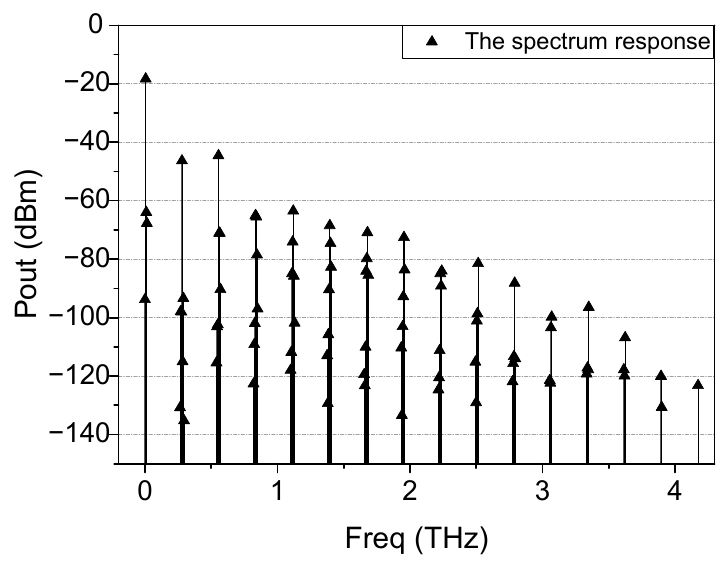
Figure 8. The spectrum response of IF output.